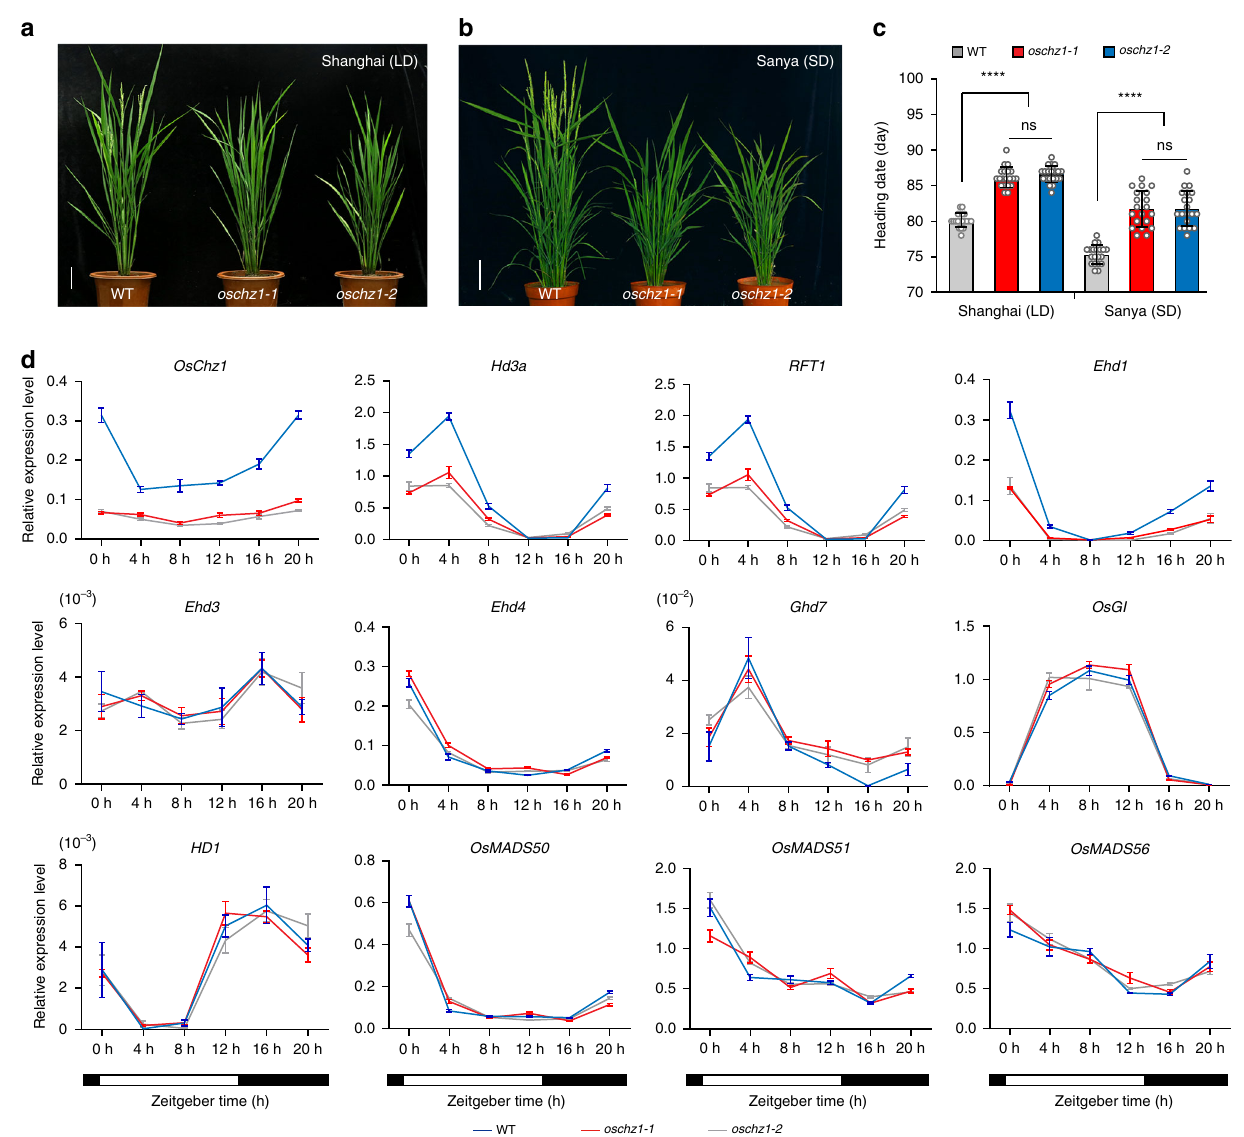
Fig. 5 Analysis of the fl owering time defects of the oschz1 mutants. a , b Representative images of wild-type (WT) and the oschz1 mutant plants at heading date stage grown under long-day (LD) and short-day (SD) photoperiod conditions, respectively. Scale bar, 10 cm. c Heading date measurements of WT and the oschz1 plants. Values are shown as means ± standard deviation from n = 20 individual plants. Statistic signi fi cances were determined by two- tailed, paired Student ’ s t -test: **** p < 0.001; ns (not signi fi cant), p > 0.05. The exact p values are 4.93 × 10 − 18 (WT vs. oschz1-1 ), 9.74 × 10 − 21 (WT vs. oschz1-2 ), 0.3432 ( oschz1-1 vs. oschz1-2 ) under LD condition; 2.82 × 10 − 12 (WT vs. oschz1-1 ), 1.50 × 10 − 12 (WT vs. oschz1-2 ), 0.9501 ( oschz1-1 vs. oschz1-2 ) under SD condition. d Relative expression levels of various rice fl owering time regulatory genes in WT and the oschz1 mutants. RNA was isolated from leaves of plants grown under LD photoperiods and was analyzed by quantitative RT-PCR. Zeitgeber time is indicated by a white bar for light period and a black bar for dark period. Values are shown as means ± standard deviation from n = 3 independent biological replicates, after normalization using rice Ubiqutin 5 as internal control. Source data underlying c and d are provided as a Source Data fi Loss of OsChz1 affects transcription and nucleosome dis- Hd3a , RFT1 , and OsChz1 , conforming our RT-qPCR results tribution of the rice genome . To investigate the effects of loss of (Supplementary Fig. 10a). A statistically signi fi cant degree of overlap was observed between these misregulated genes and the OsChz1 on gene transcription at genome-wide level, we per- total protein-coding genes (PCGs) of the rice genome (Fig. 6b). In formed RNA-seq analysis of the oschz1-1 mutant and WT rice contrast, such signi fi cant overlap was not detected for transpo- plants grown under our laboratory LD photoperiods. The analysis sable elements (TEs; Fig. 6b). Gene ontology (GO) analysis was performed in three biological replicates. We identi fi ed the indicated that genes involved in response to stress, defense, and differentially expressed genes in mutant compared to WT by DNA replication were signi fi cantly over-represented in the using DEseq2 42 . A total of 1967 genes were detected as sig- ni fi cantly (fold change ≥ 1.5 and p adj < 0.05) misregulated, with upregulated genes of the oschz1-1 mutant, and that genes 1619 of them upregulated and 348 of them downregulated involved in protein phosphorylation and biotic stimulus were (Fig. 6a), in the oschz1-1 mutant as compared to the control WT. signi fi cantly over-represented in the downregulated genes of the Among the downregulated genes in oschz1-1 , we detected Ehd1 , oschz1-1 mutant (Supplementary Fig. 10b). The fi ndings of a large